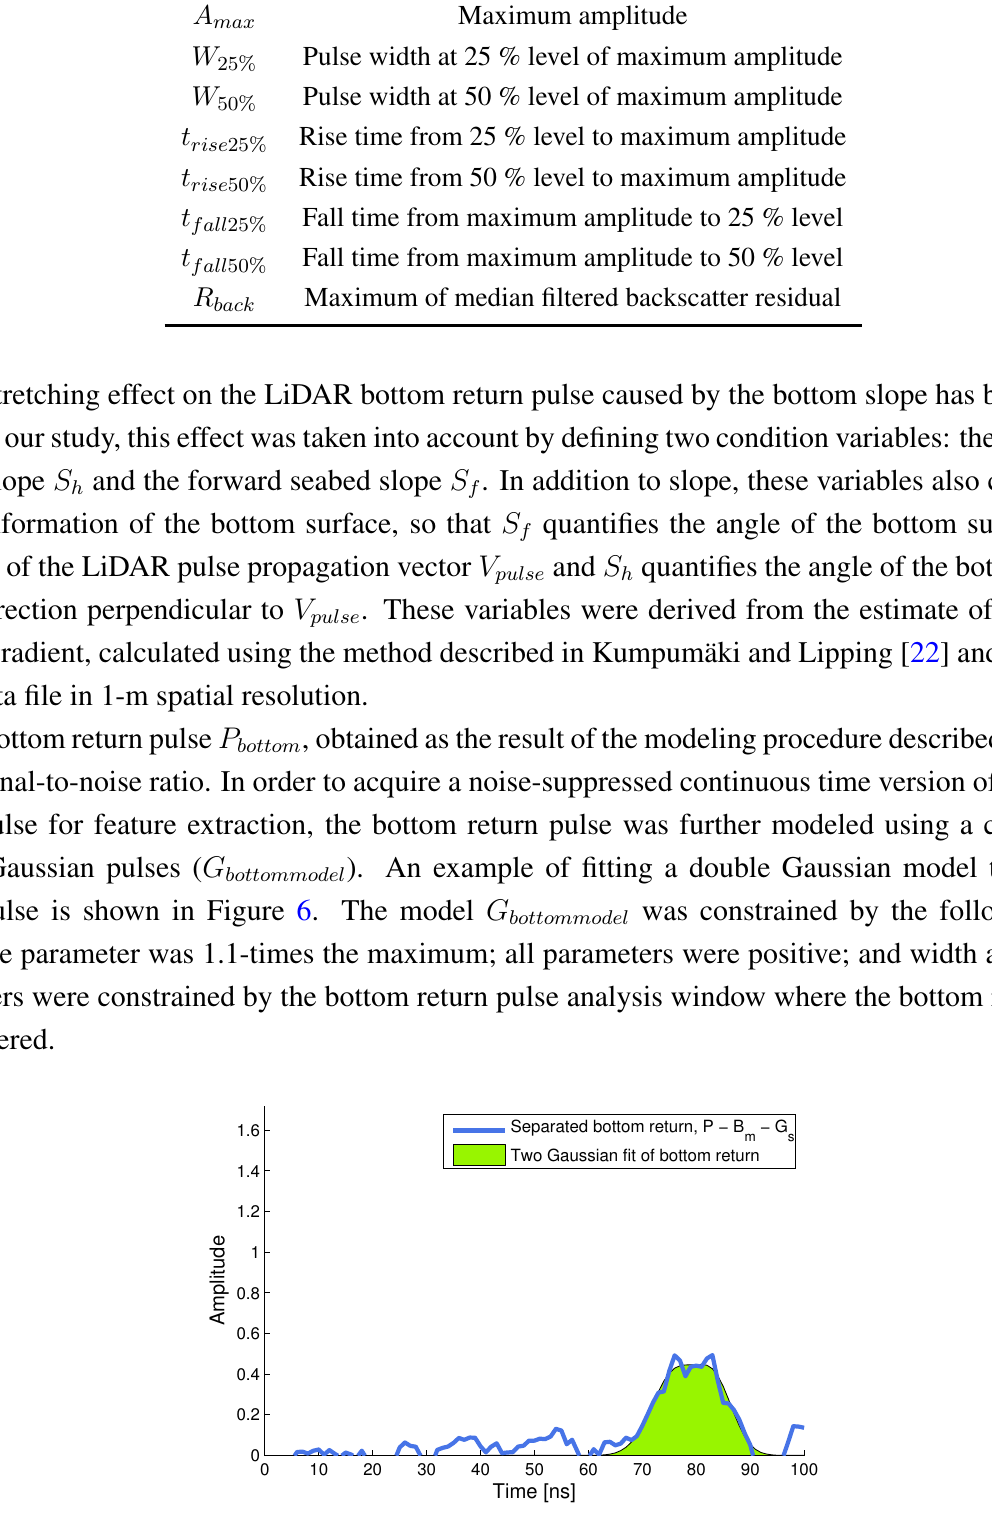
Figure 6. Modeling of the bottom return pulse extracted from the waveform shown in Figure